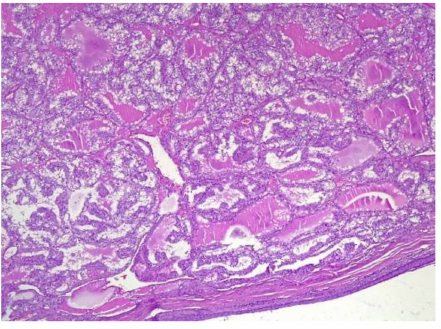
Figure 6. Struma ovarii with hyper-functional thyroid tissue. HE, 10 × .